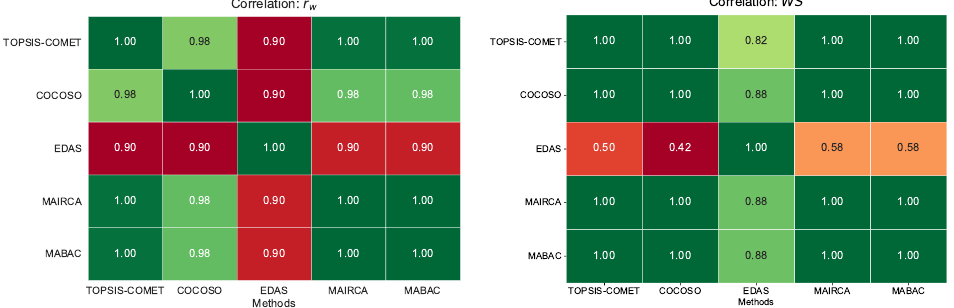
Figure 3. Visualization of rankings correlation coefficients r w and WS for each pair of MCDM method for the whole set of